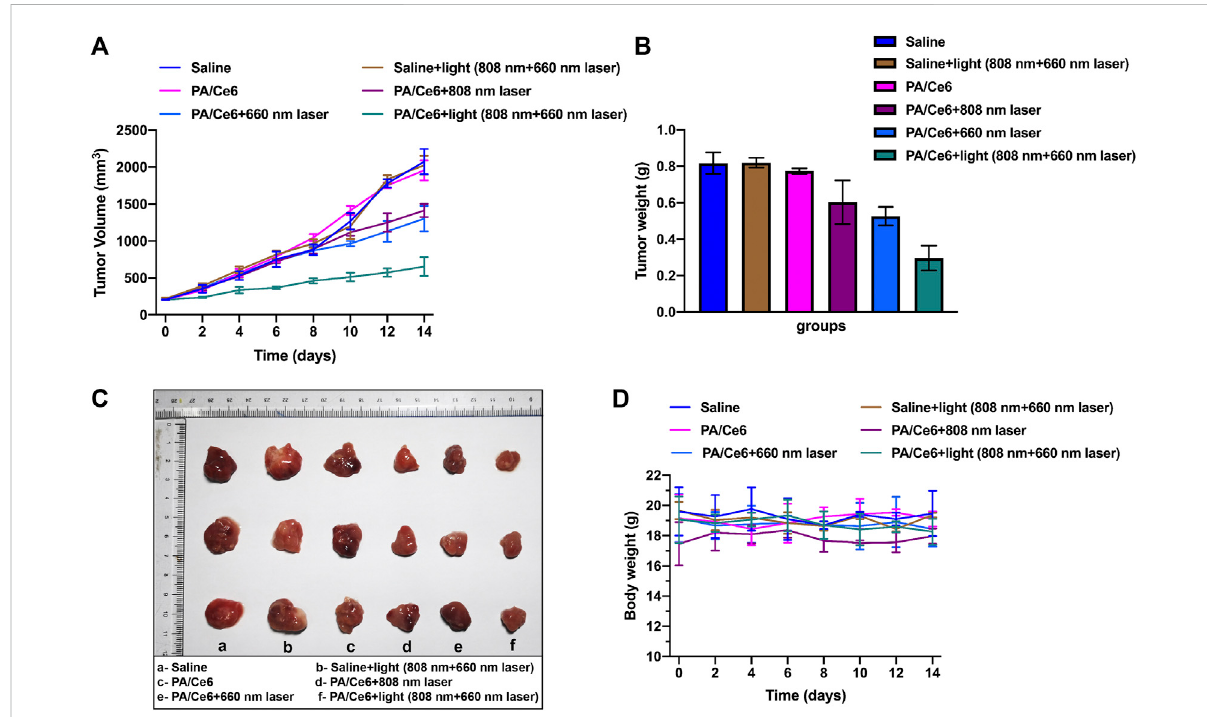
FIGURE 5 (A) Mouse tumor volume in different groups, (B) mouse tumor weight in different groups, (C) tumor photos of tumor-bearing mice, and (D) mouse body weight in different groups. For each experiment, three independent repetitions were conducted in this study. * indicates a p value of < 0.05; ** indicates a p value of <